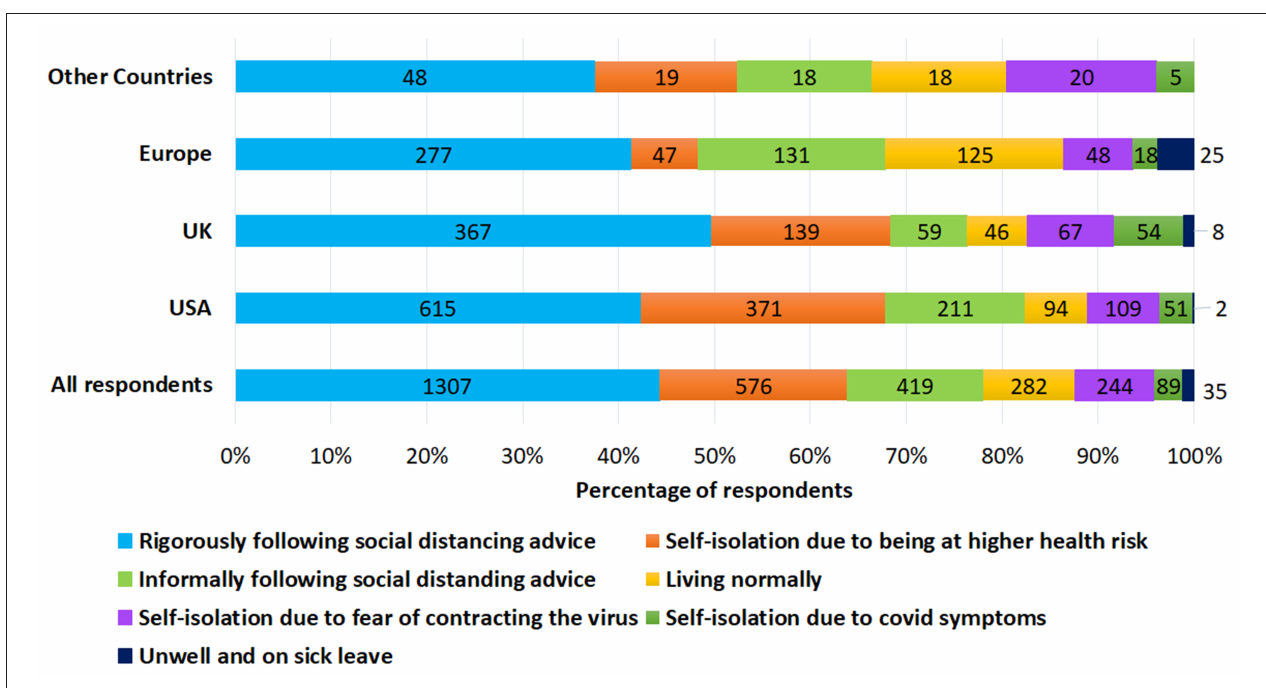
FIGURE 4 | The following of social distancing advice across different locations.